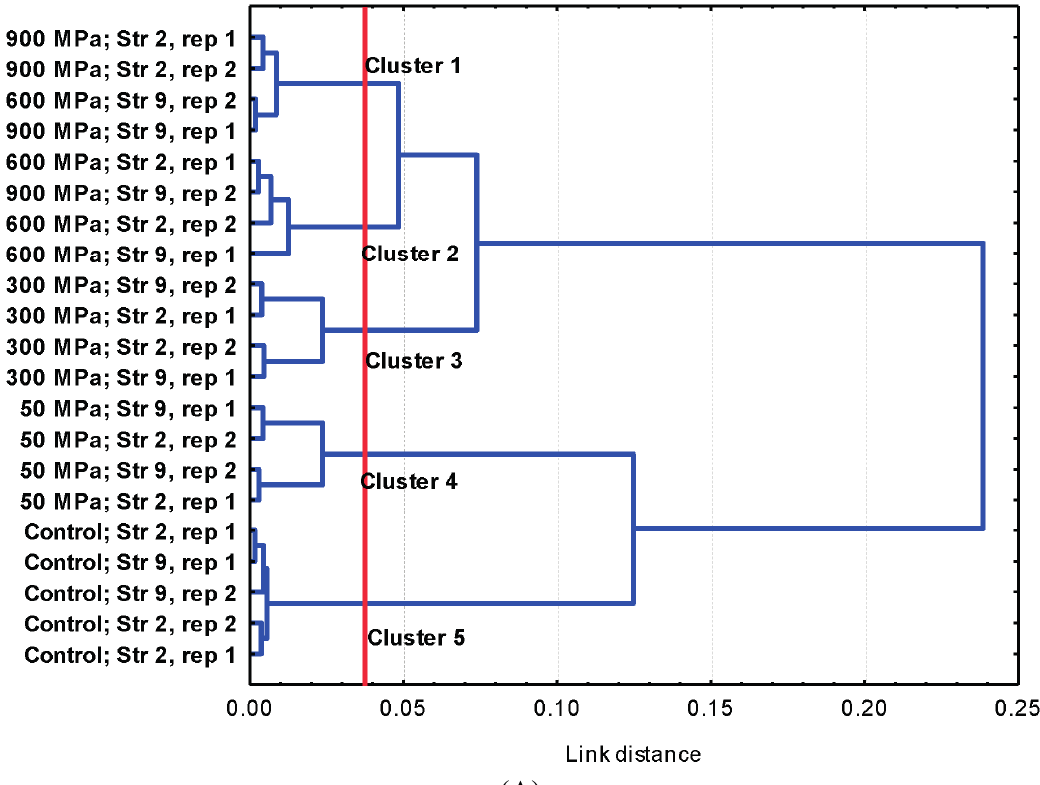
Figure 4. ( A ) Dendrogram obtained from w 4 (1200 to 900 cm − 1 ) spectral region data of two replicates (rep 1; rep 2) of strains Escherichia coli E218/02 (Strain number 2, Str 2) and Escherichia coli C-600 (Strain number 9, Str 9) untreated or HHP-treated cells, with cluster analysis performed with the Pearson product moment correlation coefficient and by the Ward algorithm method [25]; ( B ) untransformed FTIR spectra (w 3 , w 4 and w 5 spectral ranges,) of E. coli E218/02 (Str 2) before and after HHP treatment at different pressures (50, 300 and 900